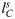
Schematic diagram of the dynamic coral-reef benthic model used.The boxes show the dynamic variables in the model, which are the proportional covers of the three functional groups modeled–hard corals, (dense) turf algae and macroalgae–and space (C, T, M and S, respectively). Arrows from one box to another represent conversion of one group to another via the dynamic processes modeled. The processes are grouped into three categories, pertaining to growth (G), recruitment (R) and mortality (M). Underneath the boxes and arrows diagram is the set of differential equations specifying how the variables change over time. There is no equation for S because it is a dependent variable that is determined by 1–C–T–M. Terms in the equations represent the dynamic processes modeled, and are numbered to match the corresponding arrows in the diagram. rC and αCrC are the rates of growth of hard corals over space and turf algae, respectively, in the absence of macroalgae; lCs and εClCs are the exogenous rates of recruitment of hard corals over space and turf algae, respectively, whereas lCb and εClCb are the corresponding endogenous rates of recruitment; dC is the mortality rate of hard corals from processes other than overgrowth; ζT is the maximum growth rate of turf algae in space, which is decreased by grazing, measured by the grazing effort θ that takes values from 0 to 1; gT is the maximum grazing rate on turf algae; rM, γMCrM and γMTrM are the growth rates of macroalgae over space, hard corals and turf algae, respectively; gM is the maximum grazing rate on macroalgae; and βM is the negative effect of macroalgae on the growth rate of hard corals. Further details of these parameters and the equations are found in Fung and others (2011) [33].